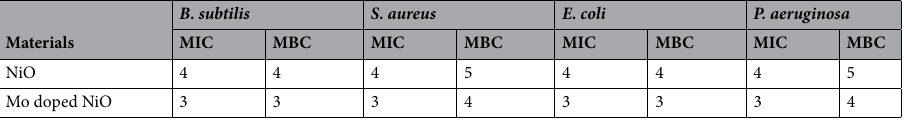
Table 1. MIC and MBC of NiO NPs and Mo doped NiO. Data presented are average values of three replicates.